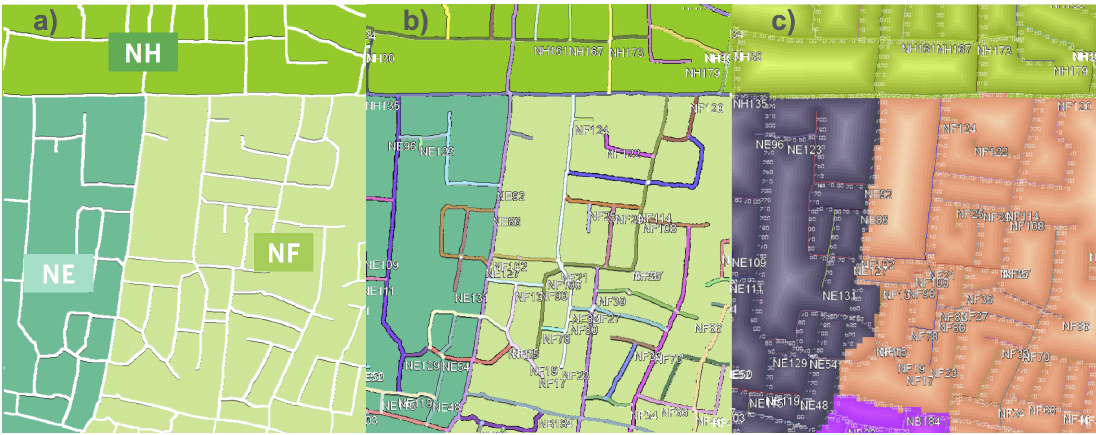
Figure 8. Hierarchical Labeling. Naming of ( a ) regions; ( b ) roads; and ( c ) addresses is